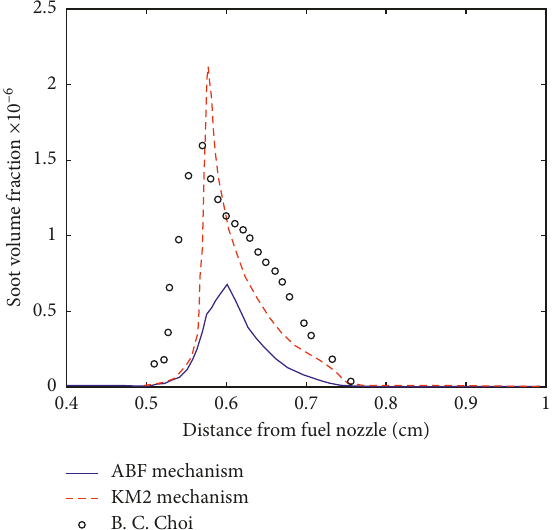
Figure 7: Profiles of average soot particle size under various exit velocities.